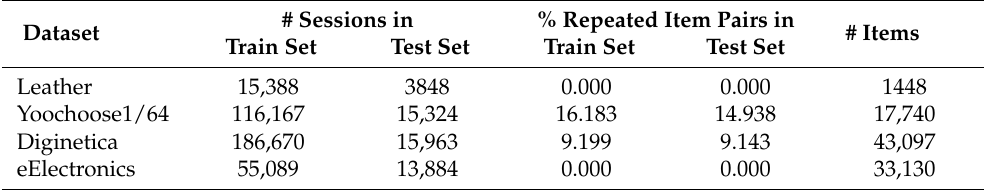
Table 2. Datasets